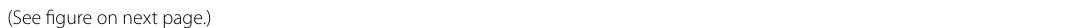
figure on next Fig. 1 66 years old postmenopausal woman with osteoporotic vertebrae. a DWI of lumbar vertebrae with different b ‑values (0, 400, 800 mm 2 /s). ADC values for L1, L2, L3, and L4 were achieved 0.26, 0.20, 0.19, and 0.17 intensity in L1, L2, L3, and L4 vertebral bodies with SNR of 5.60, 6.12, 6.21, and 6.54, respectively. b DXA shows the T‑score values of 0.1, and 3.6 for L1, L2, L3, and L4, −